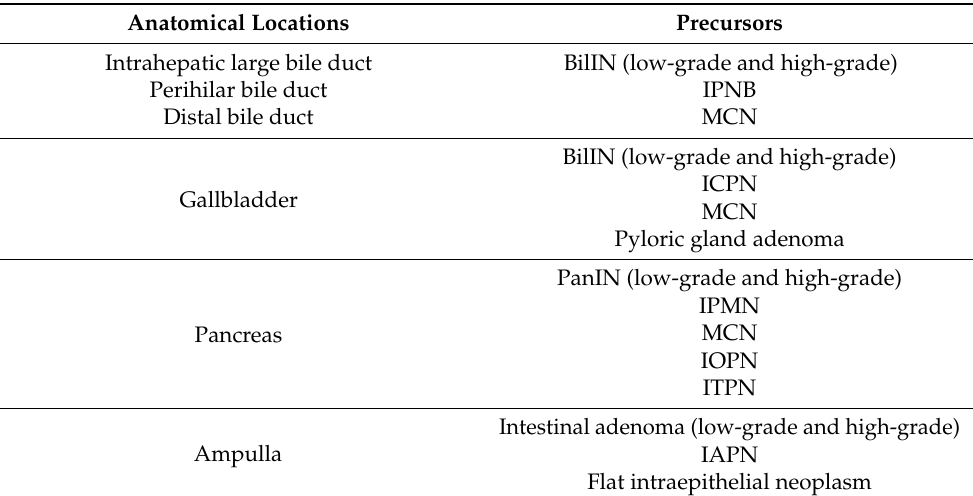
Table 2. Precursor lesions of pancreatobiliary